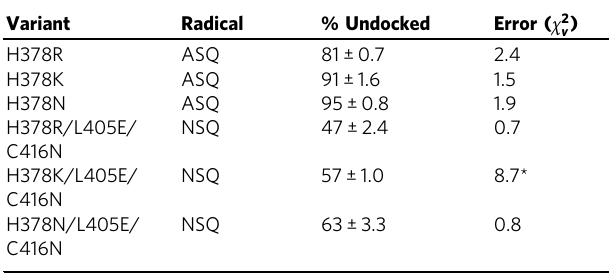
Residual X 2 error estimatesare determinedin DDand indicatethe robustness of fi t betweenthe experimental data and the distance reconstruction. A residual X 2 error value in the range of 2 or lower is indicative of a good fi t. The variance in the population of the undocked state is also given. The H378K/L405E/C416N variant (*) has a relatively high error and is discussed in Fig. S16.